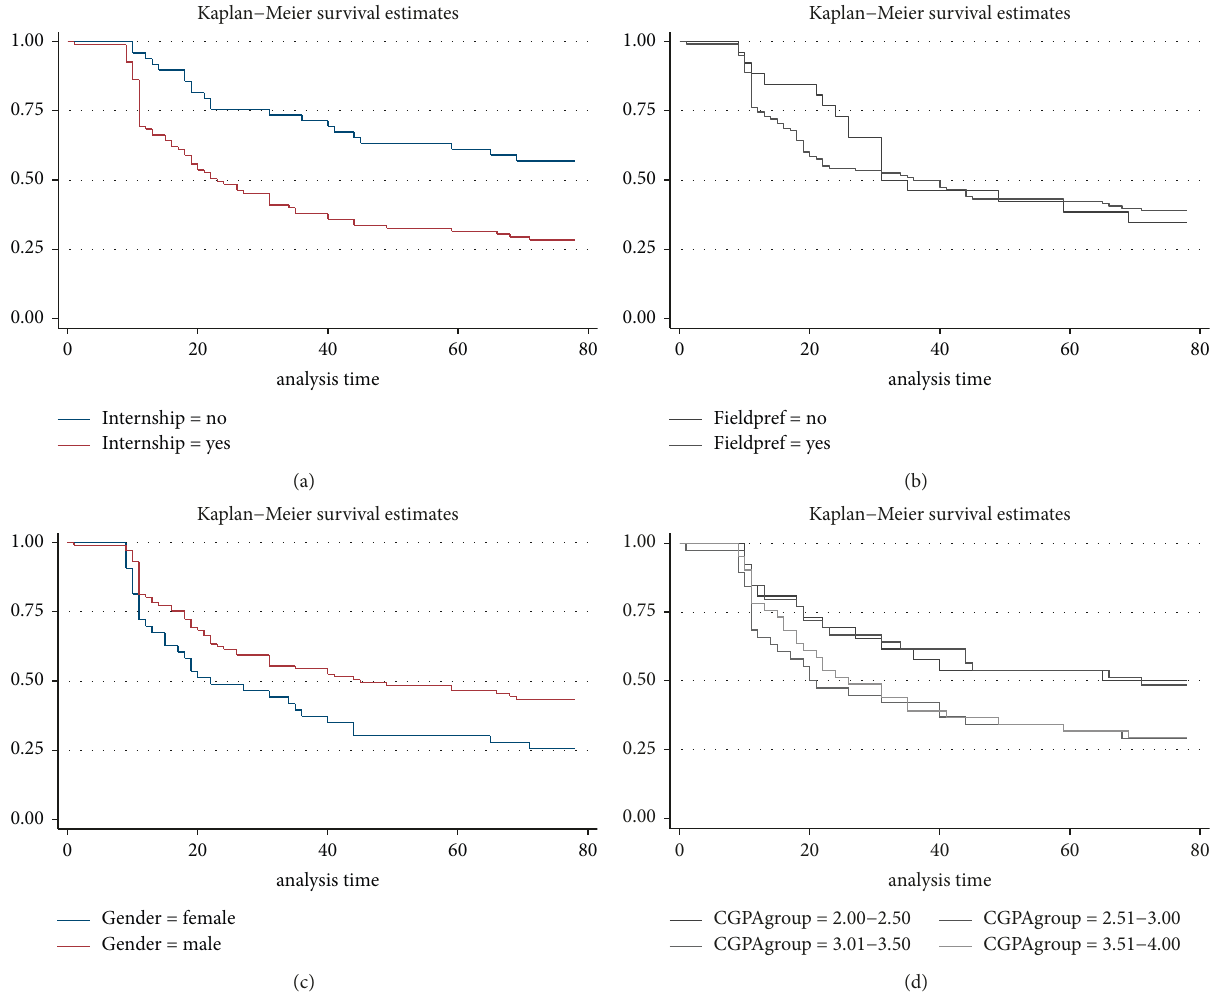
Figure 5: (a) Kaplan–Meier curve for internship. (b) Kaplan–Meier curve for field of study. (c) Kaplan–Meier curve for gender. (d) Kaplan–Meier curve for